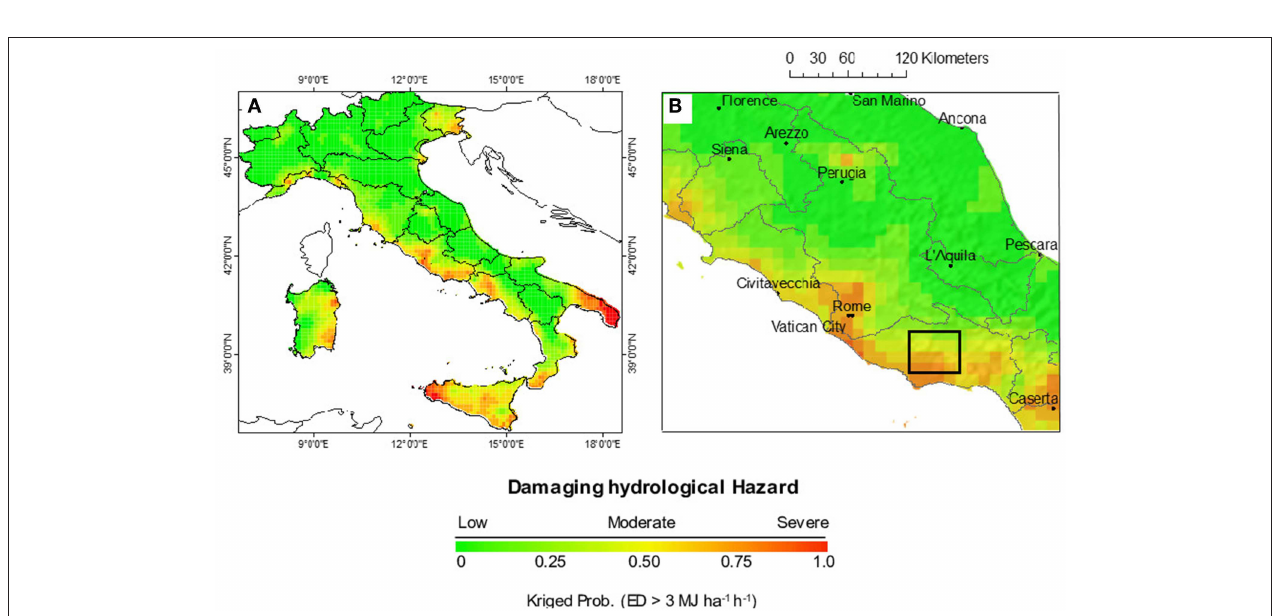
FIGURE 4 | Spatial patterns of kriged-probability maps exceeding the erosivity density threshold-value z k of 3 MJ ha − 1 h − 1 for (A) August and (B) September across Italy for the period 2002–2011.